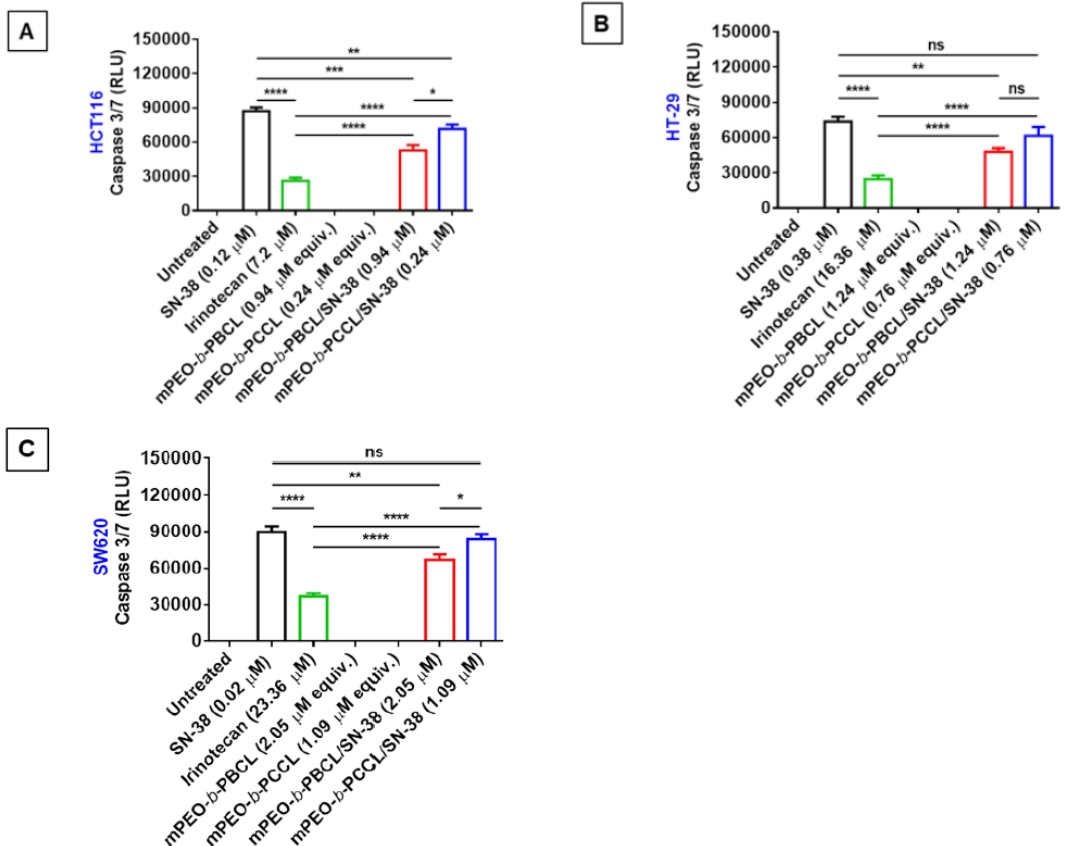
Figure 6. Caspase activity assay for free SN-38, irinotecan, mPEO- b -PBCL, mPEO- b -PCCL, mPEO- b -PBCL / SN-38, and mPEO- b -PCCL / SN-38 in ( A ) HCT116, ( B ) HT-29, and ( C ) SW620 cell lines. The cells were treated with the media containing the respective IC 50 (24 h) concentrations of free SN-38, irinotecan, mPEO- b -PBCL / SN-38, and mPEO- b -PCCL / SN-38 for 6 h. Treated amounts of mPEO- b -PBCL and mPEO- b -PCCL were equivalent to the amounts of mPEO- b -PBCL / SN-38 and mPEO- b -PCCL / SN-38, respectively. The untreated (control) cells received only 0.1% DMSO. The significances of the di ff erences are indicated as * p ≤ 0.05, ** p ≤ 0.01, *** p ≤ 0.001, and **** p ≤ 0.0001 following a two-way ANOVA multiple comparison test, which was followed by Tukey’s method. Data are expressed as mean ± SD ( n = 6). ns: no significance.